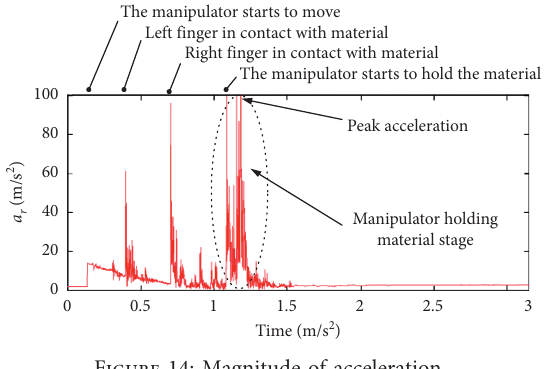
Figure 14: Magnitude of acceleration.